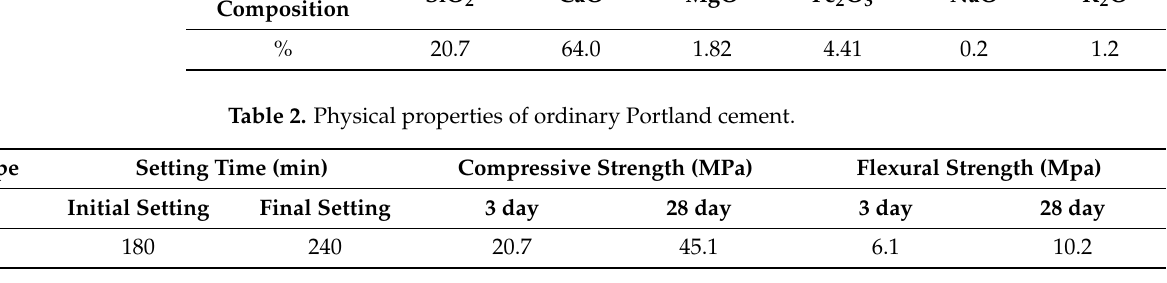
Table 3. Main chemical constituents of fly